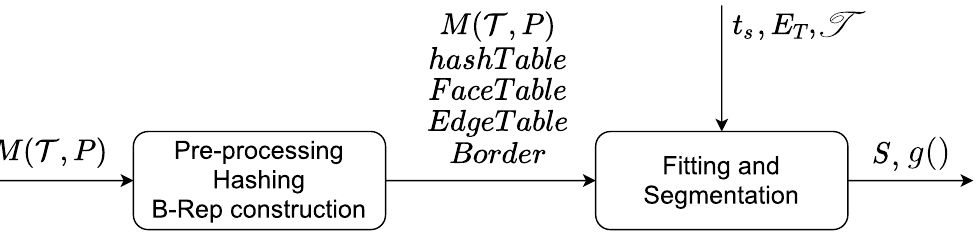
Figure 1. Overall primitive extraction